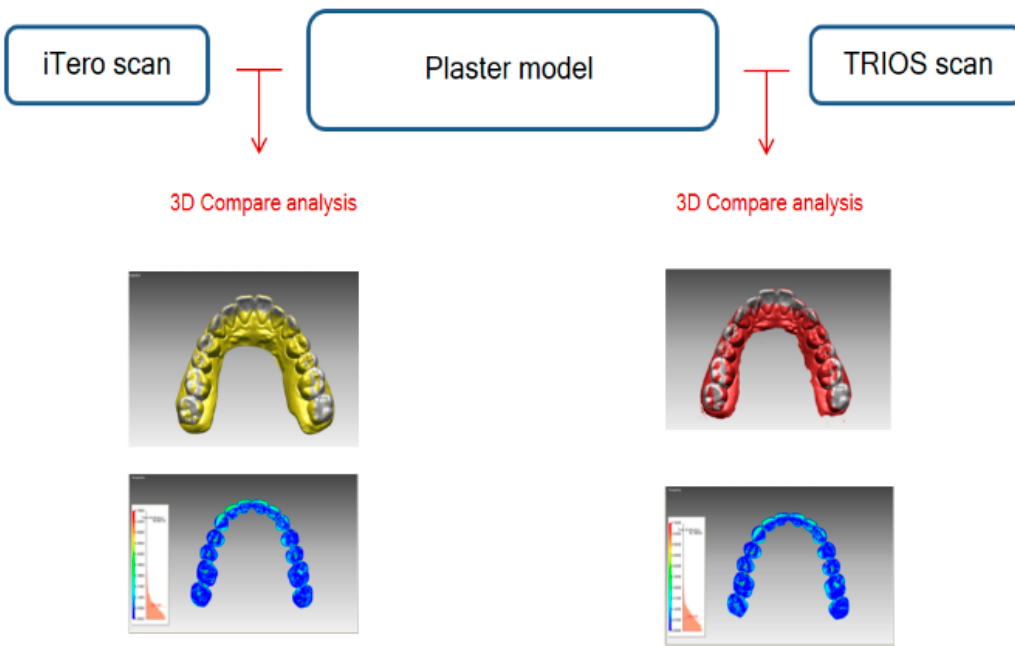
Figure 1. Illustration of comparison between intraoral scan and model scan.